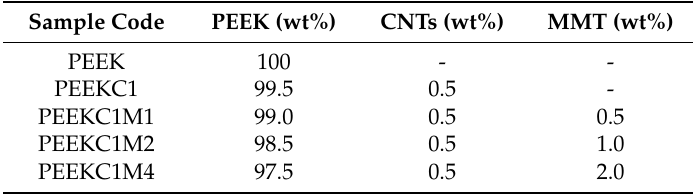
Figure 1. Schematic illustration of the fabrication of multi-walled carbon nanotubes (CNTs)/organically modified montmorillonite (MMT) hybrids and poly(ether ether ketone) (PEEK)/CNTs/MMT nanocomposites. Table 1. The Designation and composition of the samples.